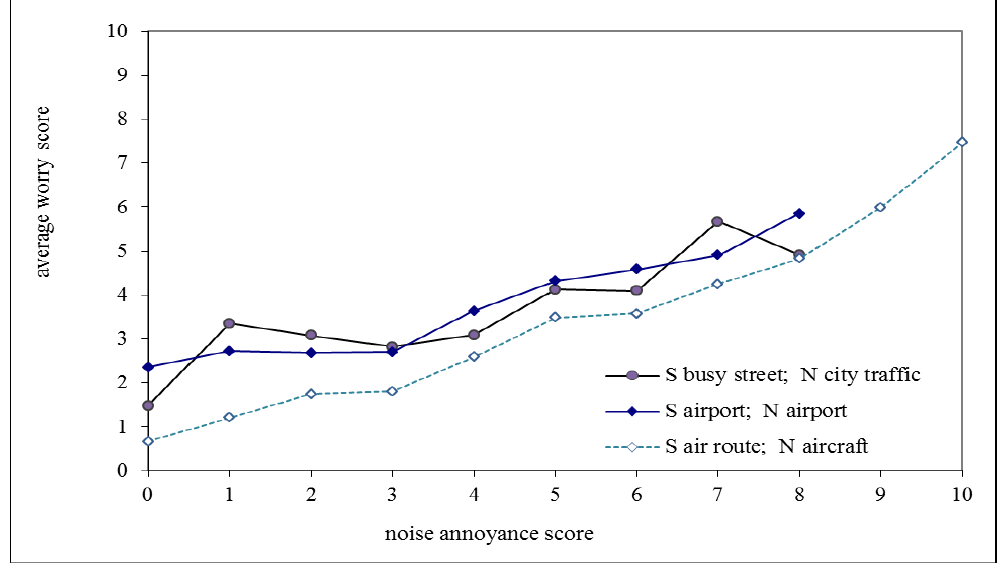
Figure 4. Relation between average worry score and noise annoyance score for respondents living in one of three situations (close to aircraft route, close to airport and on busy street) and who report to hear the noise source. Legend: S = situation (living on/close to…); N = noise source.